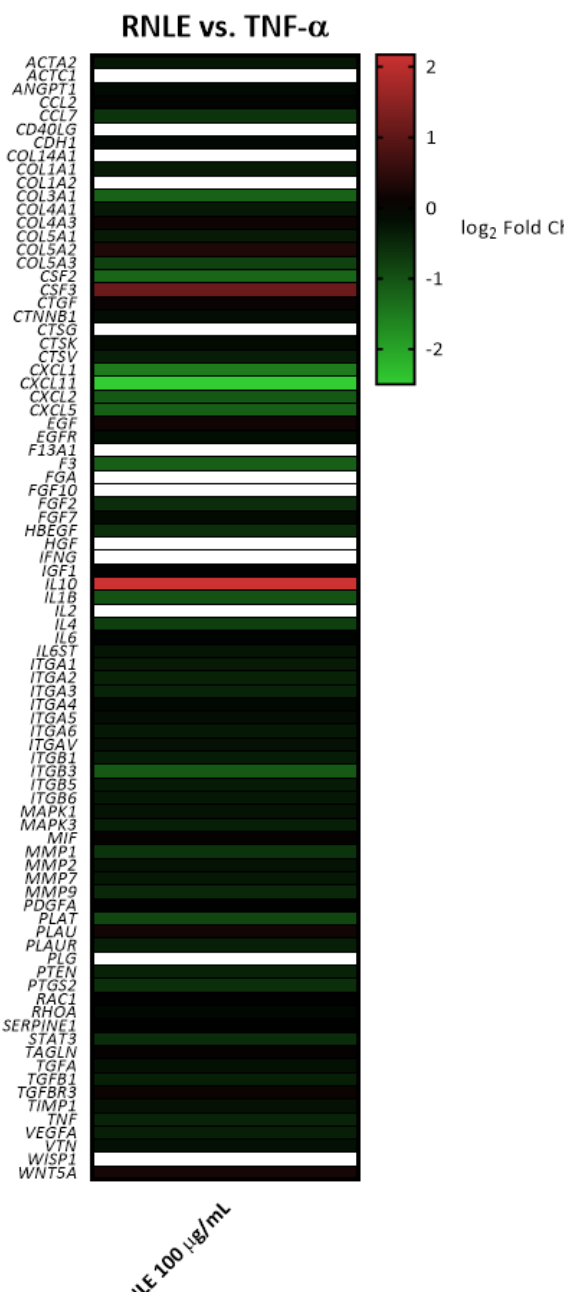
Figure 3. Heatmap depicting the effect on gene expression induced by RNLE treatment (100 µg/mL) in HaCaT cells stimulated with TNF-α (10 ng/mL, 6 h). The color scale represents gene upregulation ( red ) and downregulation ( green ) compared to TNF-α-induced condition (log 2 fold change = 0, black ). In white, genes present in the panel but not expressed in the experimental model.